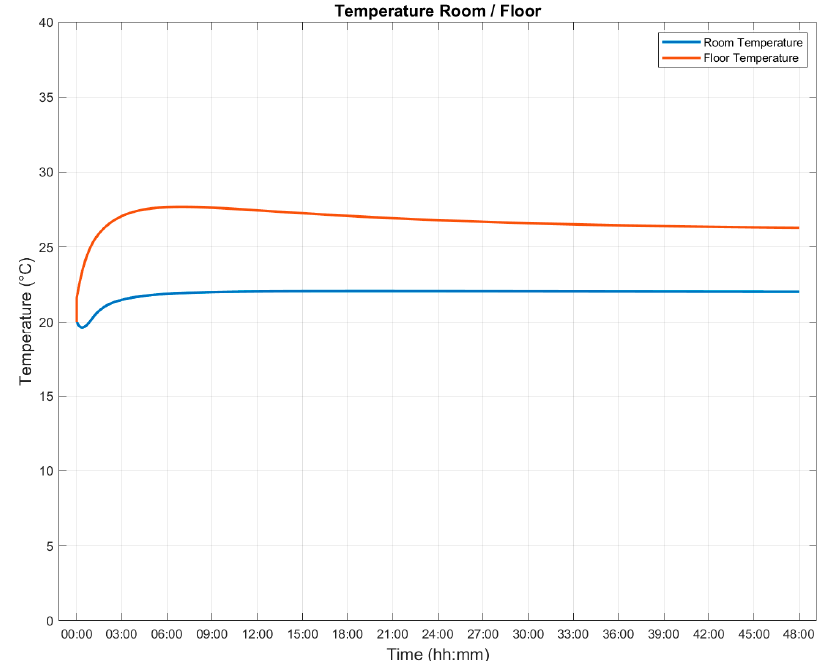
Figure 9. Room and floor temperature control.